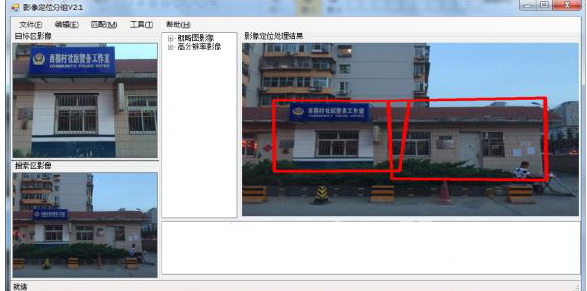
Figure 17. The result of Multi-image visual